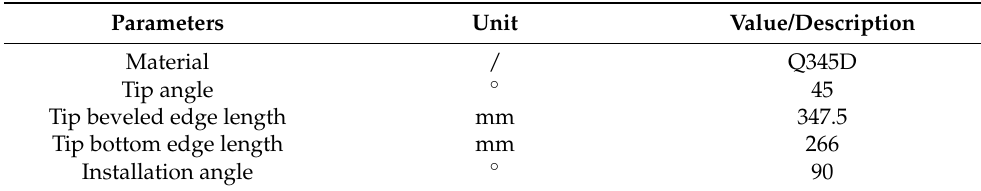
Table 5. Claw tip